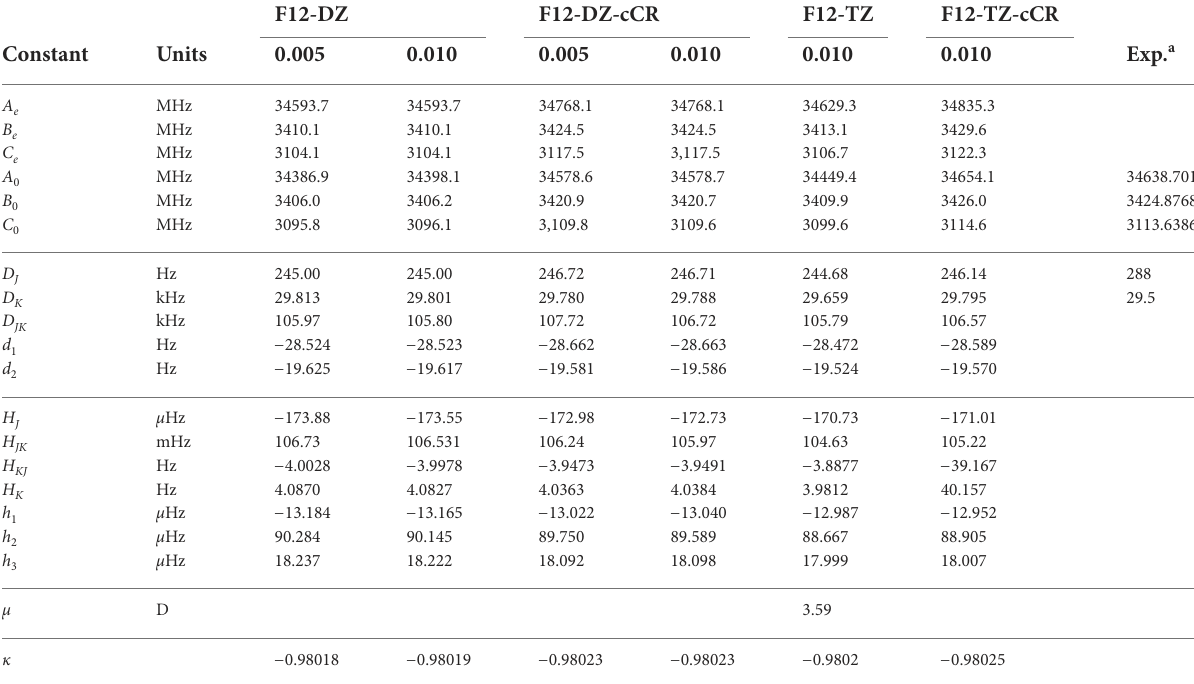
TABLE 3 Rotationalconstantsof c -C 3 HC 2 Hcomparedtopreviousexperiment a .